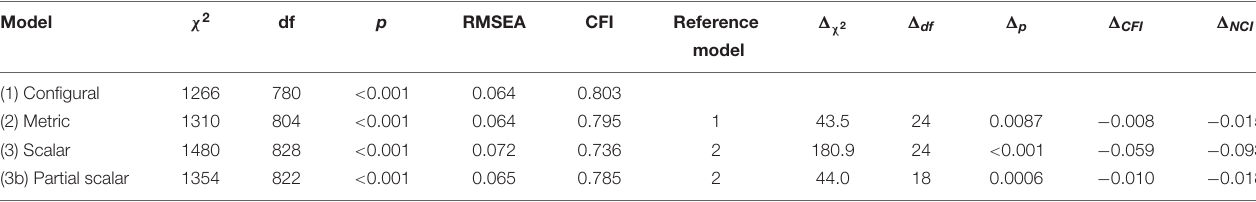
TABLE 4 | Model fit in testing factorial invariance of inmate and civilian samples ( N = 305).